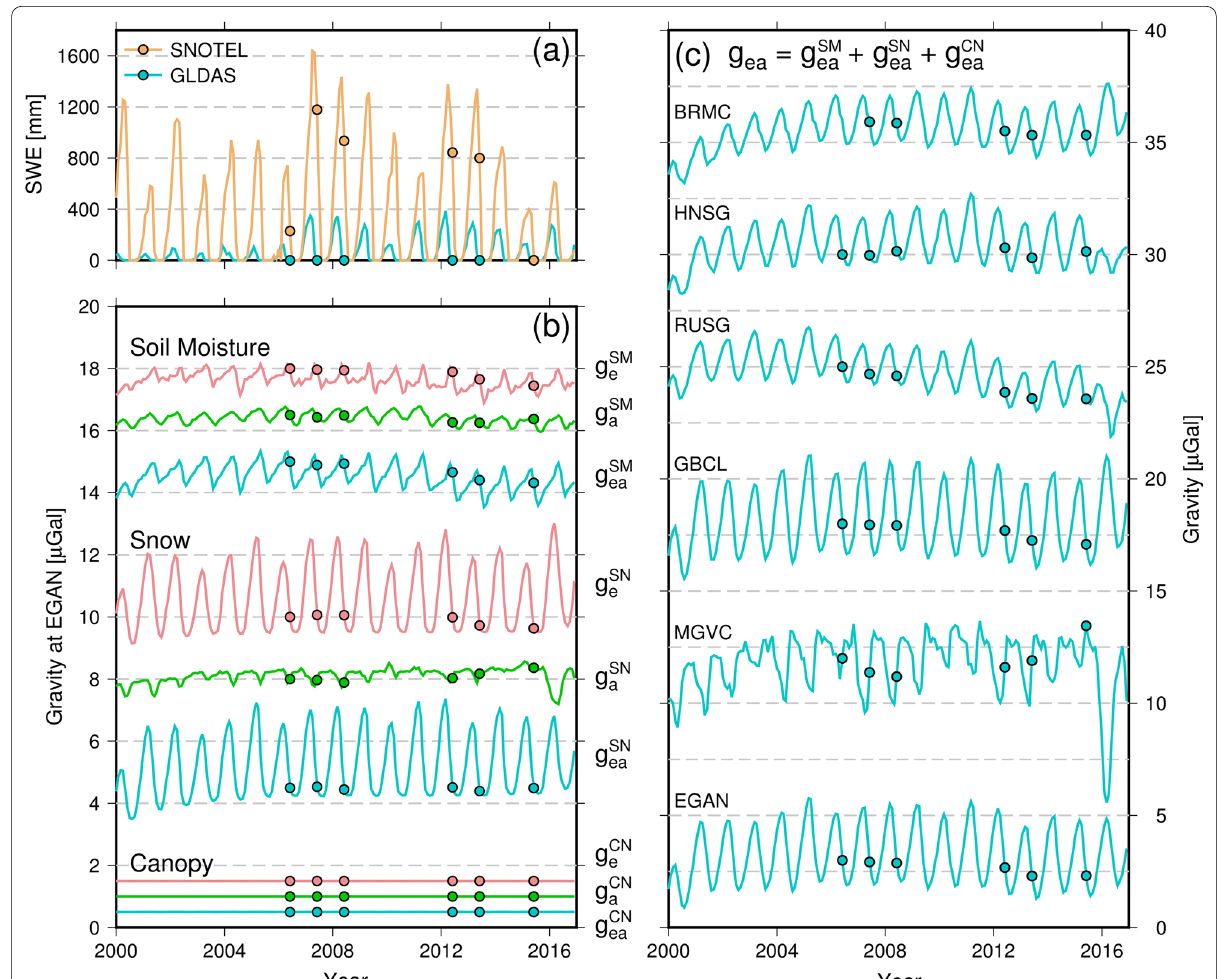
Fig. 3 Gravity change associated with hydrological effect. a An orange line indicates the snow water equivalent (SWE) value observed at Long Lake’s weather station (green triangle in Fig. 1), and a cyan line indicates the SWE value at the EGAN’s gravity point obtained from the GLDAS-2.1 data-set (Rodell et al. 2004). b Monthly gravity change at EGAN, calculated from the GLDAS-2.1 model (Rodell et al. 2004). Colored lines in the top, middle, and bottom of the panel indicate the calculated gravity changes associated with mass variations in soil moisture, snow and canopy, respectively. Pink and green lines indicate the gravity changes due to the elastic loading deformation and mass attraction ( g e and g a ), respectively, and cyan lines indicate the sum of the two effects ( g e + g a ). c Cyan lines indicate the hydrological gravity changes at six AG points in SE-AK, calculated as the sum of the loading/attraction effects due to soil moisture, snow and canopy (see the panel b ). In each panel, the circles indicate the values at the time when the AG values were measured in